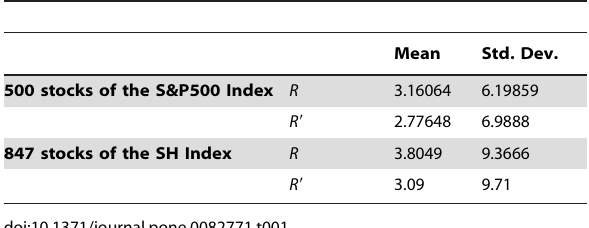
Table 1. Mean value and standard deviation of breakouts ( R ) and breakdowns ( R 9